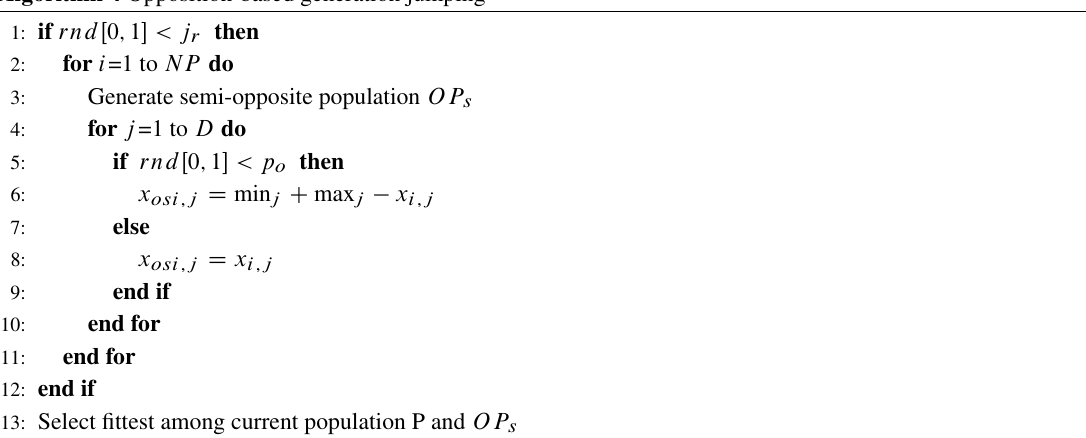
Algorithm 4 Opposition-based generation